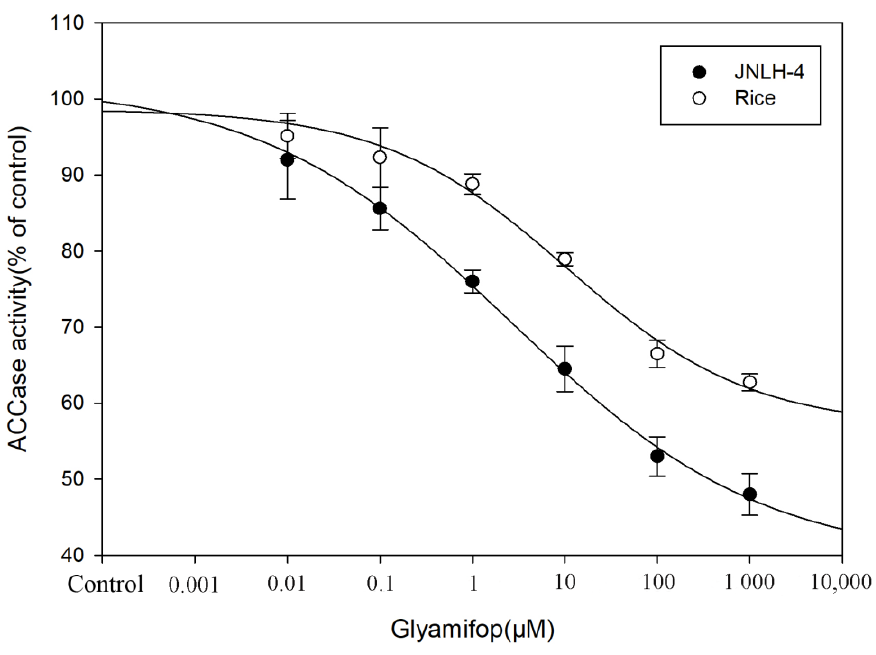
Figure 3. In vitro inhibition of Leptochloa chinensis JNLH-4 and Japonica rice (HuaiDao 5) ACCase activity by Glyamifop.